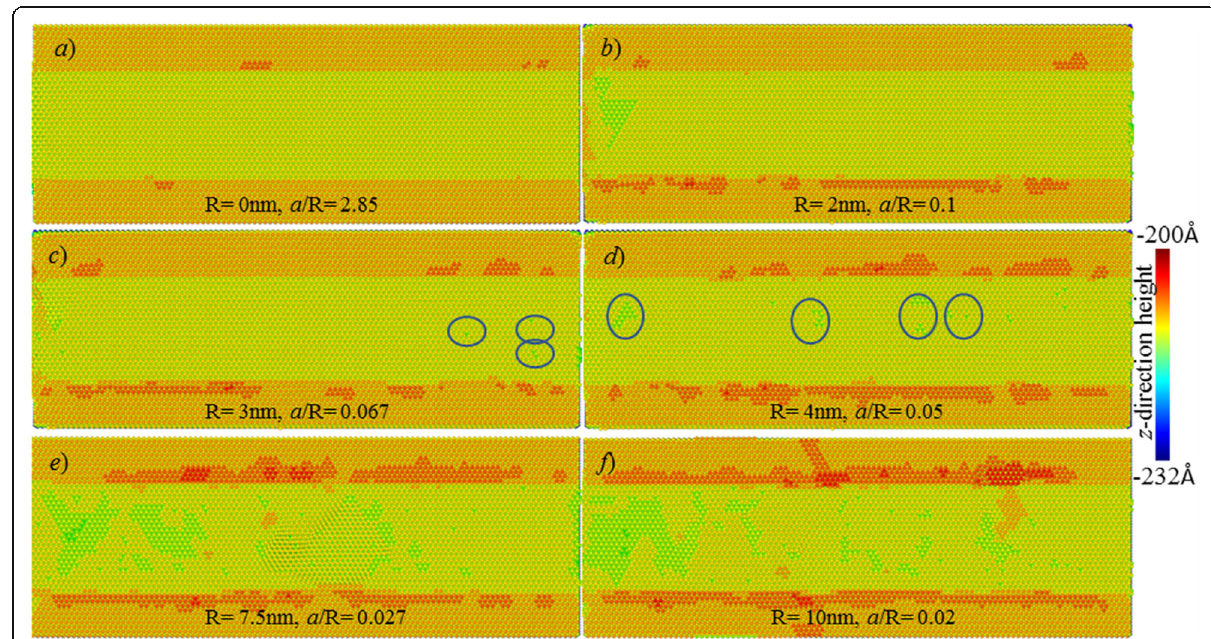
Fig. 6 Effects of tool edge radius on surface topographies. Atoms are coloured based on their z-direction heights